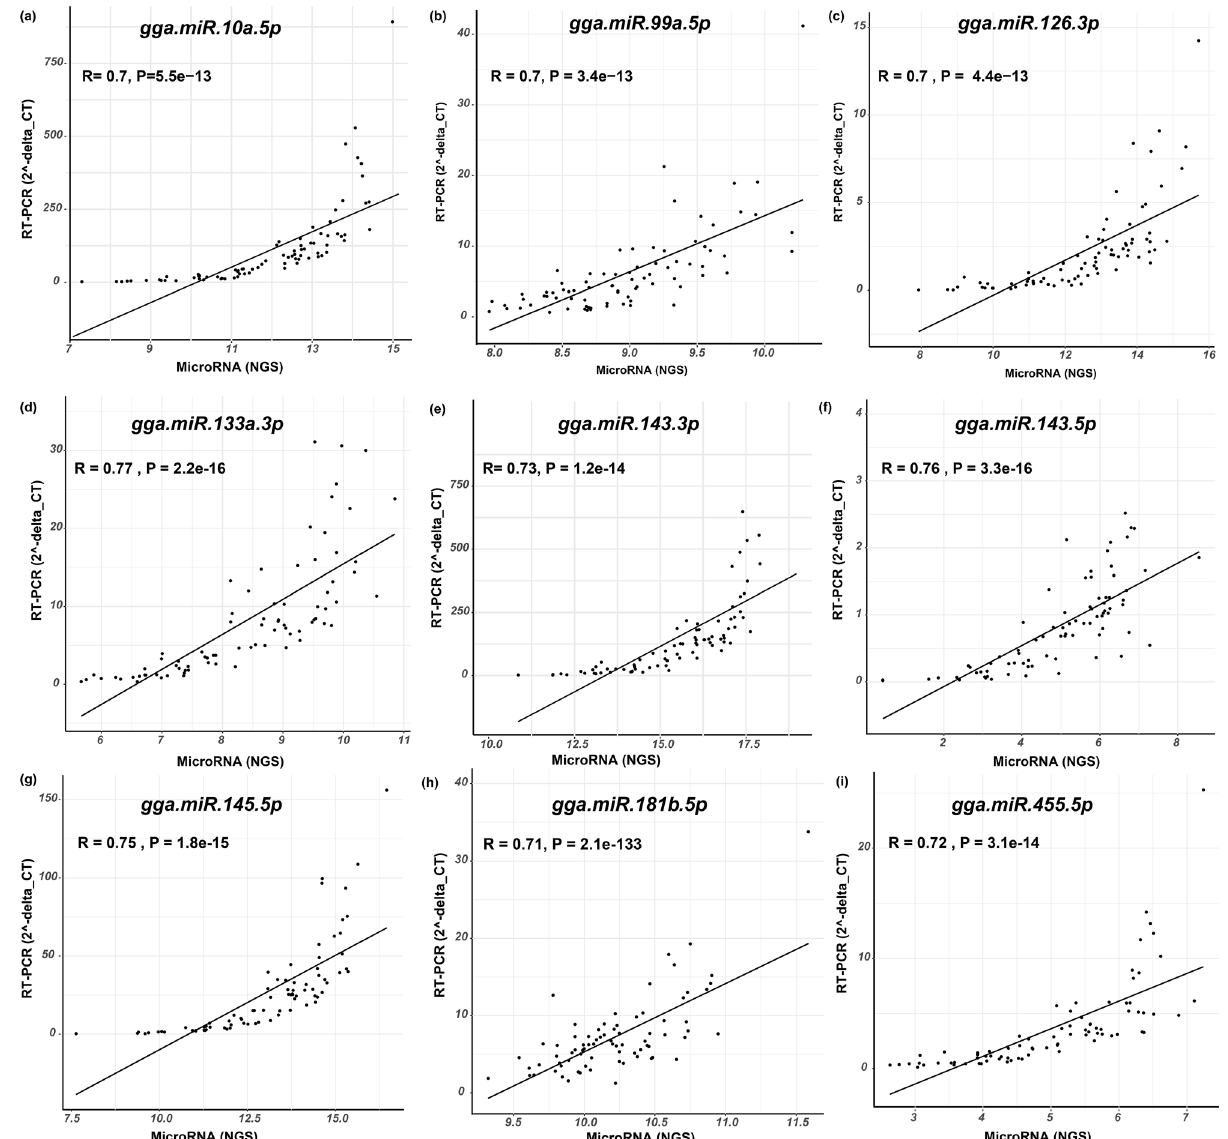
Figure 13. Validation of qPCR and NGS data of selected miRNAs. Scatter plots indicated the validation of NGS selected miRNAs data and qPCR miRNA with respect to their coefficient of correlation (r) ranging from 0.70 to 0.76 and P <